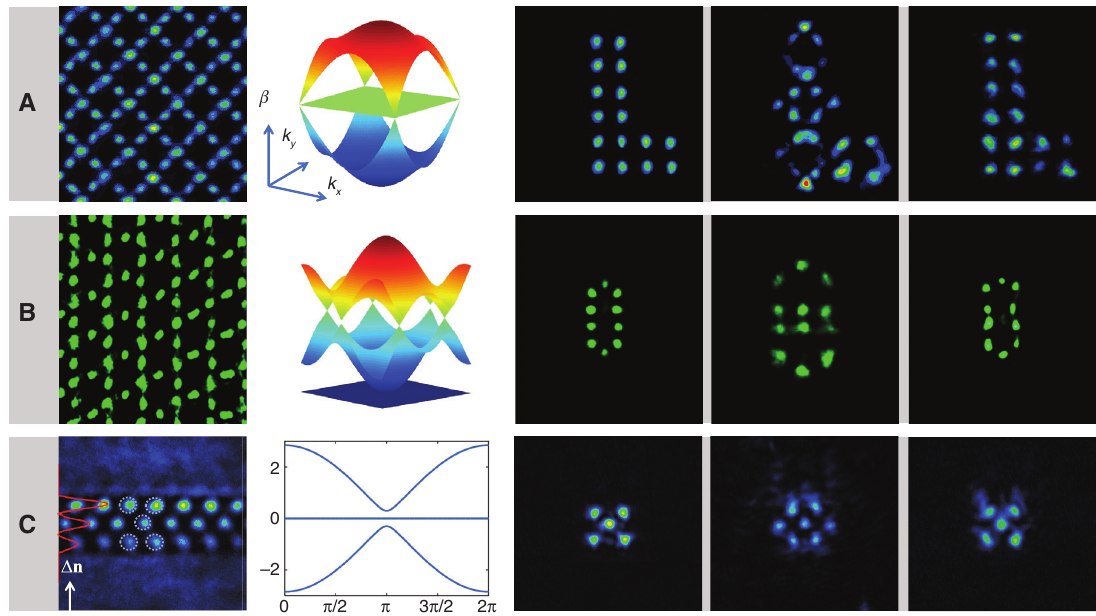
Figure 5: Examples of the compact localized states observed in optically induced flat-band photonic lattices. Shown are experimental results of (A) linear image propagation through a Lieb photonic lattice [35] and (B) a bound-state transmission in a pyrochlore-like (Kagome) photonic lattice [36]. (C) Experimental observation of a quincunx-shaped CLS which spans over two unit cells in a photonic rhombic lattice [84]. From left to right: the lattice, calculated band structure in the tight-binding approximation, probe beam input, in-phase output, and out-of-phase